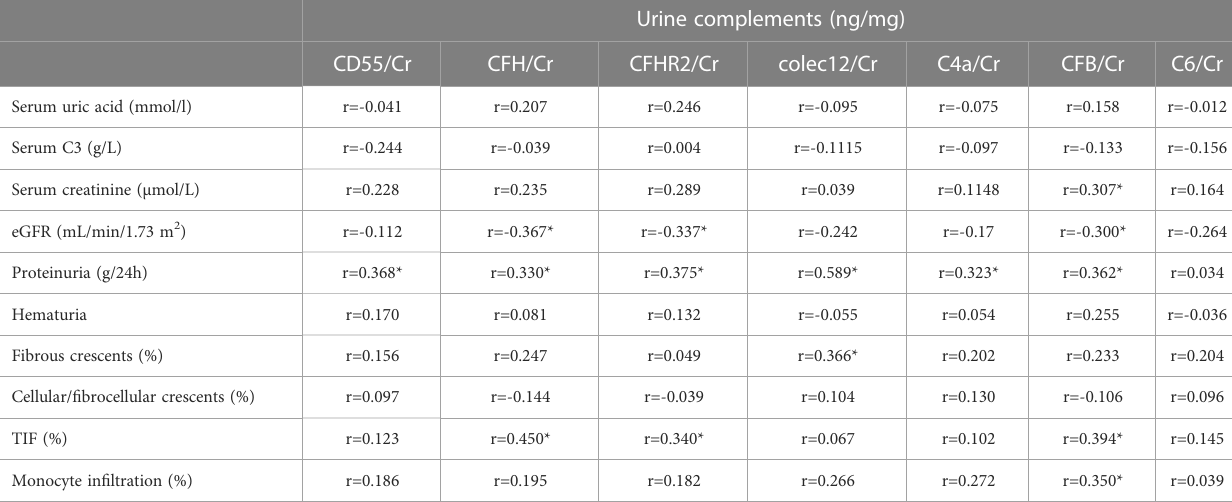
TABLE 3 Correlation analysis of seven urinary complement-related proteins with laboratory and pathological parameters in patients with IgAN.